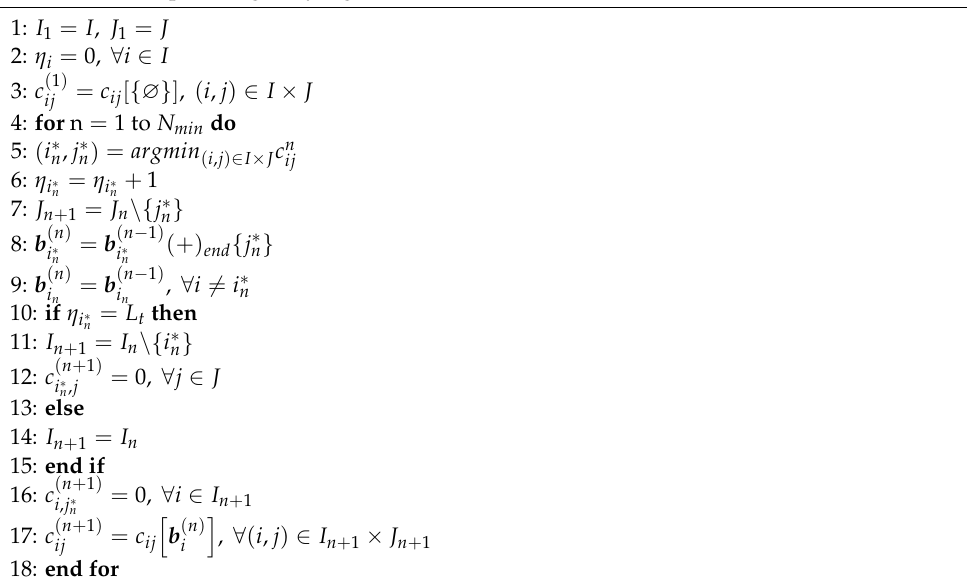
Algorithm 4 Sequential greedy algorithm for Accumulated Distance